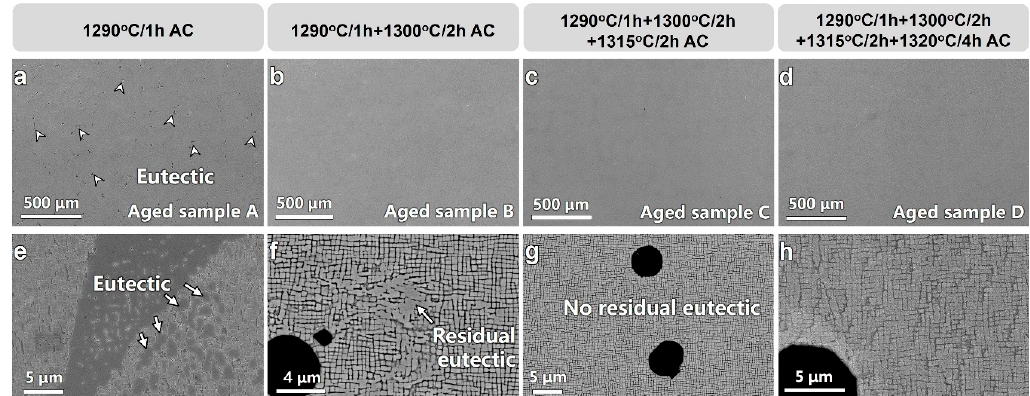
Figure 6. E ff ects of solid solution (SS) processing on the microstructures after aging at 1120 ◦ C / 4 h air cooling (AC) + 870 ◦ C / 24 h AC ( a – d ) low magnificent secondary electron (SE) images showing overall microstructures after a full cycle of SS and aging heat treatment; ( e – h ) The corresponding high-magnification images showing microstructures in the interdendritic region of ( a – d ). There are clearly residual eutectics / coarse γ (cid:48) phases in ( e , f ), but not in ( g – h ).